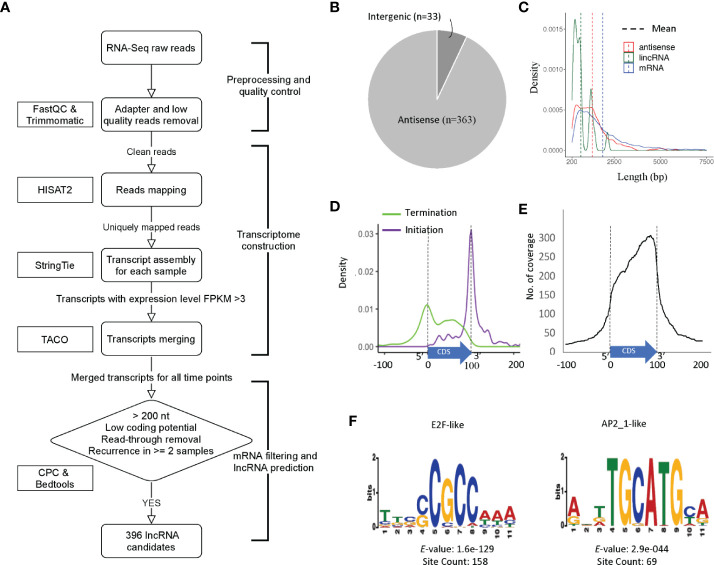
Prediction and characterization of lncRNAs in C. parvum.  (A) Pipeline of lncRNA prediction. (B) Genomic location of predicted lncRNAs. (C) The distribution of transcript lengths for mRNA genes, antisense RNAs and lincRNA candidates with mean lengths indicated. (D) Antisense transcription initiation and termination position relative to the sense CDS (normalized to 0–100). (E) Abundance and position of sense CDS (normalized to 0–100) covered by antisense transcription. (F) Top two enriched upstream motifs within 100 bp, the same strand (+) of lncRNA candidates.